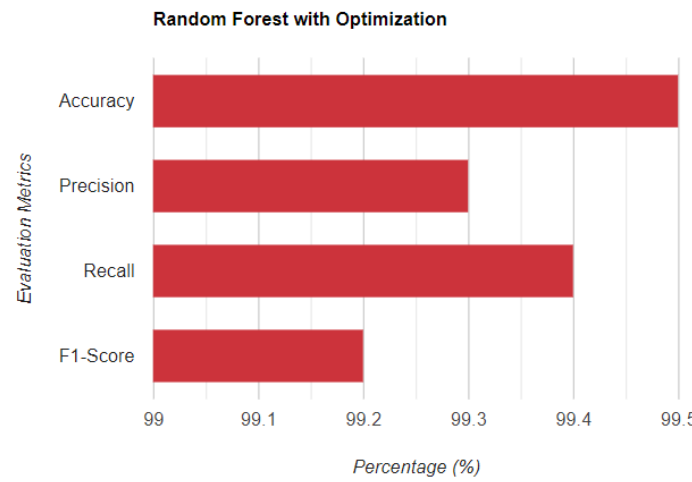
Figure 16. Random Forest Algorithm Performance After Optimization.